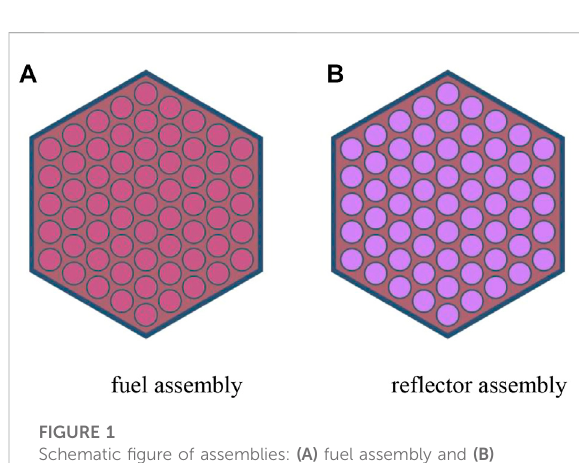
FIGURE 1 Schematic fi gure of assemblies: (A) fuel assembly and (B) re fl ector assembly.